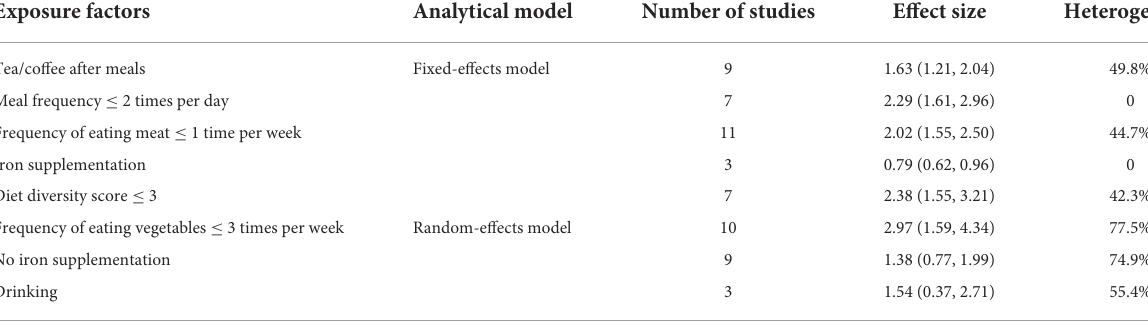
TABLE 2 Exposure factors associated with dietary habits of pregnant women.